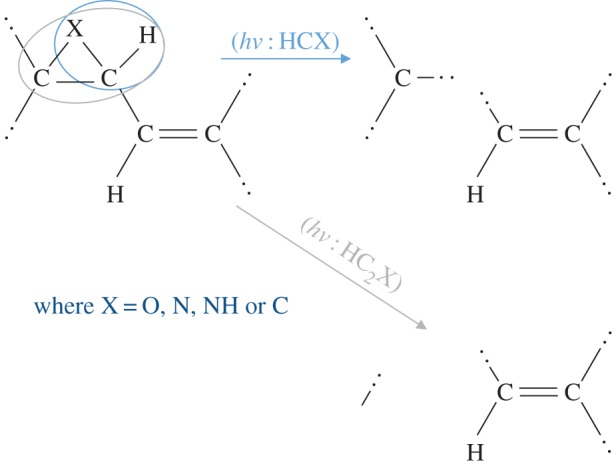
A speculative epoxide/aziridine FUV photolysis-driven pathway to nanoparticle erosion in the tenuous ISM. In this case, the product radicals could include: HCO, HC2O, HCN, HNC and HCNH and perhaps also HC2NH, l-C3H and c-C3H if C+ inserts into olefinic C=C bonds to form a cyclopropene ring, somewhat analogous to epoxide and aziridine formation.